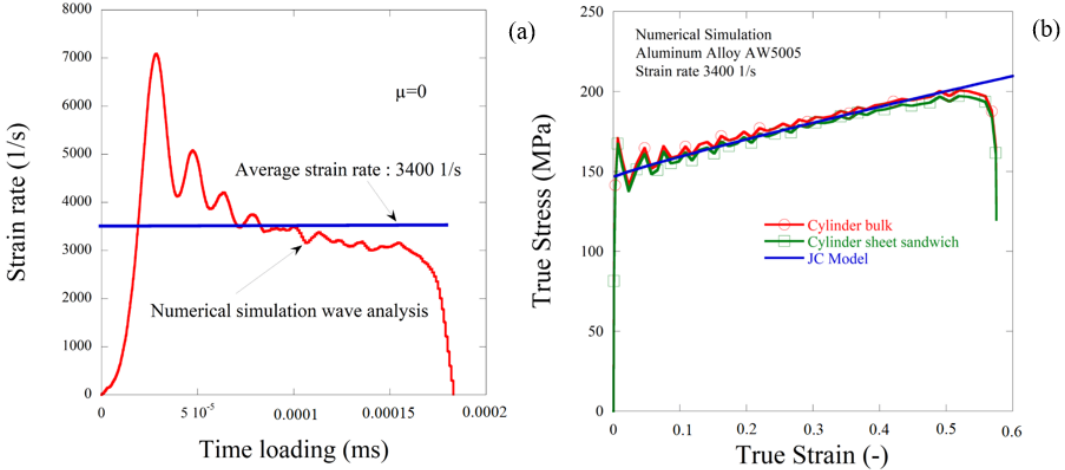
Figure 7. ( a ) Strain rate for an impact velocity 13 m/s and ( b ) comparison between numerical results with the JC model (without friction correction) using cylinder and cylinder sheet specimen configuration.